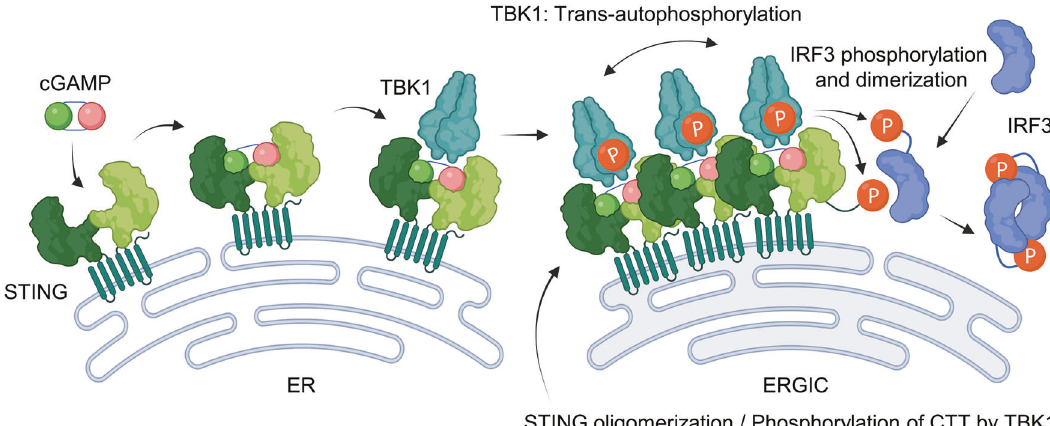
Fig. 4 Regulation of STING and the downstream signaling pathway. Upon binding to cGAMP, STING undergoes a conformational change, and then, the dimers oligomerize. STING oligomerization recruits TBK1 and promotes autotransphosphorylation of TBK1 at the ERGIC. Activated TBK1 phosphorylates the CTT of STING to generate IRF3 docking sites and then phosphorylates the recruited